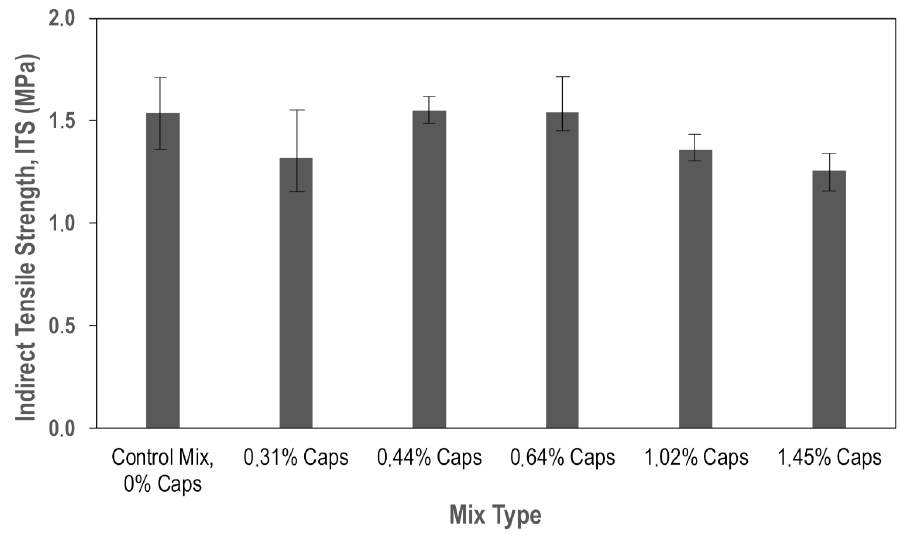
Figure 3. Indirect tensile strength test results.